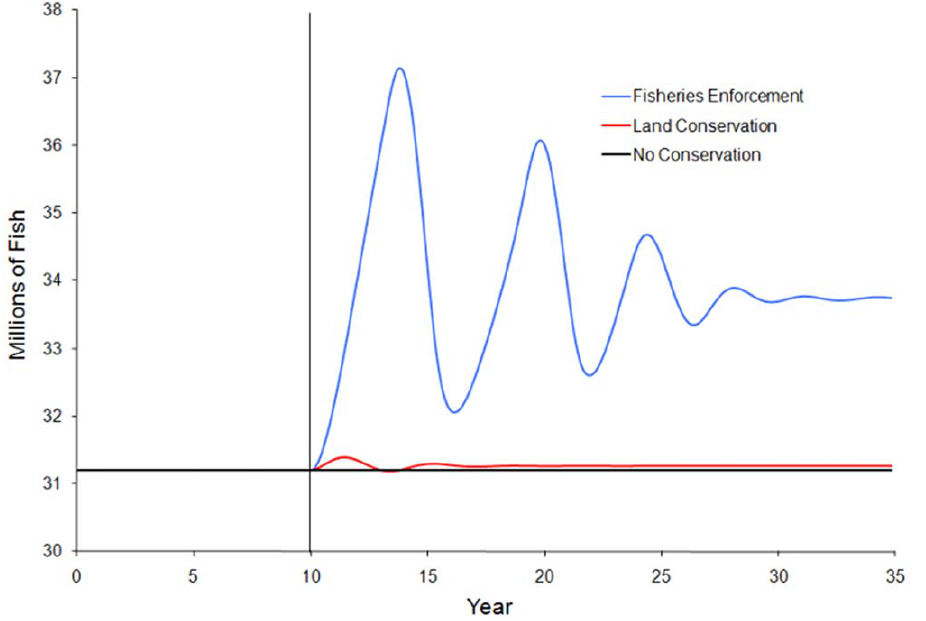
Figure 3. Impacts of the various marine conservation strategies on fish stocks. Conservation strategies are implemented at year 10, denoted by the vertical line. Both conservation strategies lead to an increase in fish stock in this scenario.